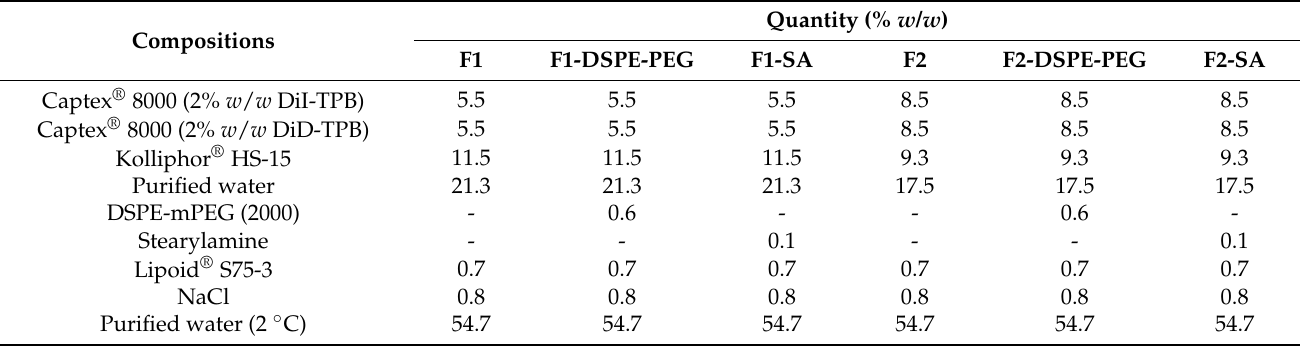
Table 2. Composition of different types of